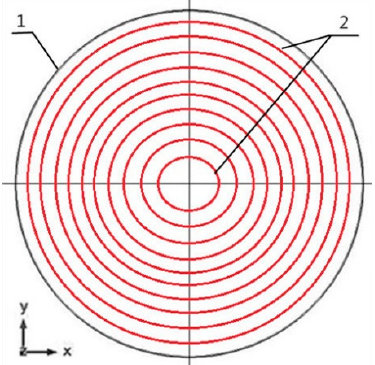
Figure 3. The ten circular 3D curves in MNP device.